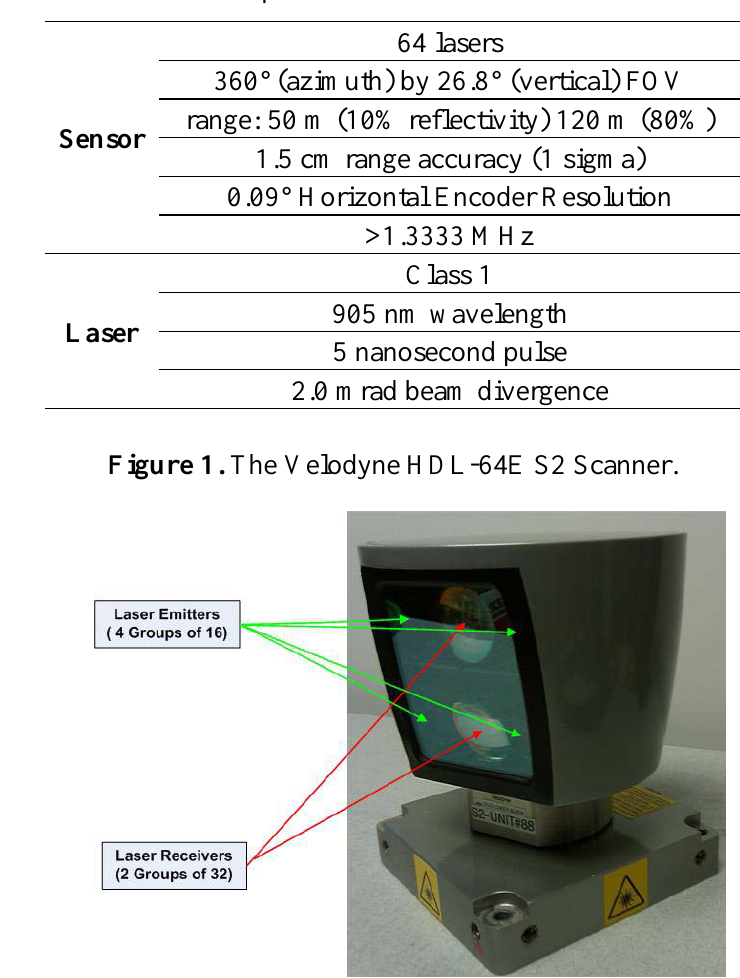
Table 1. Manufacturer Specifications for the HDL-64E S2 Scanner [2].